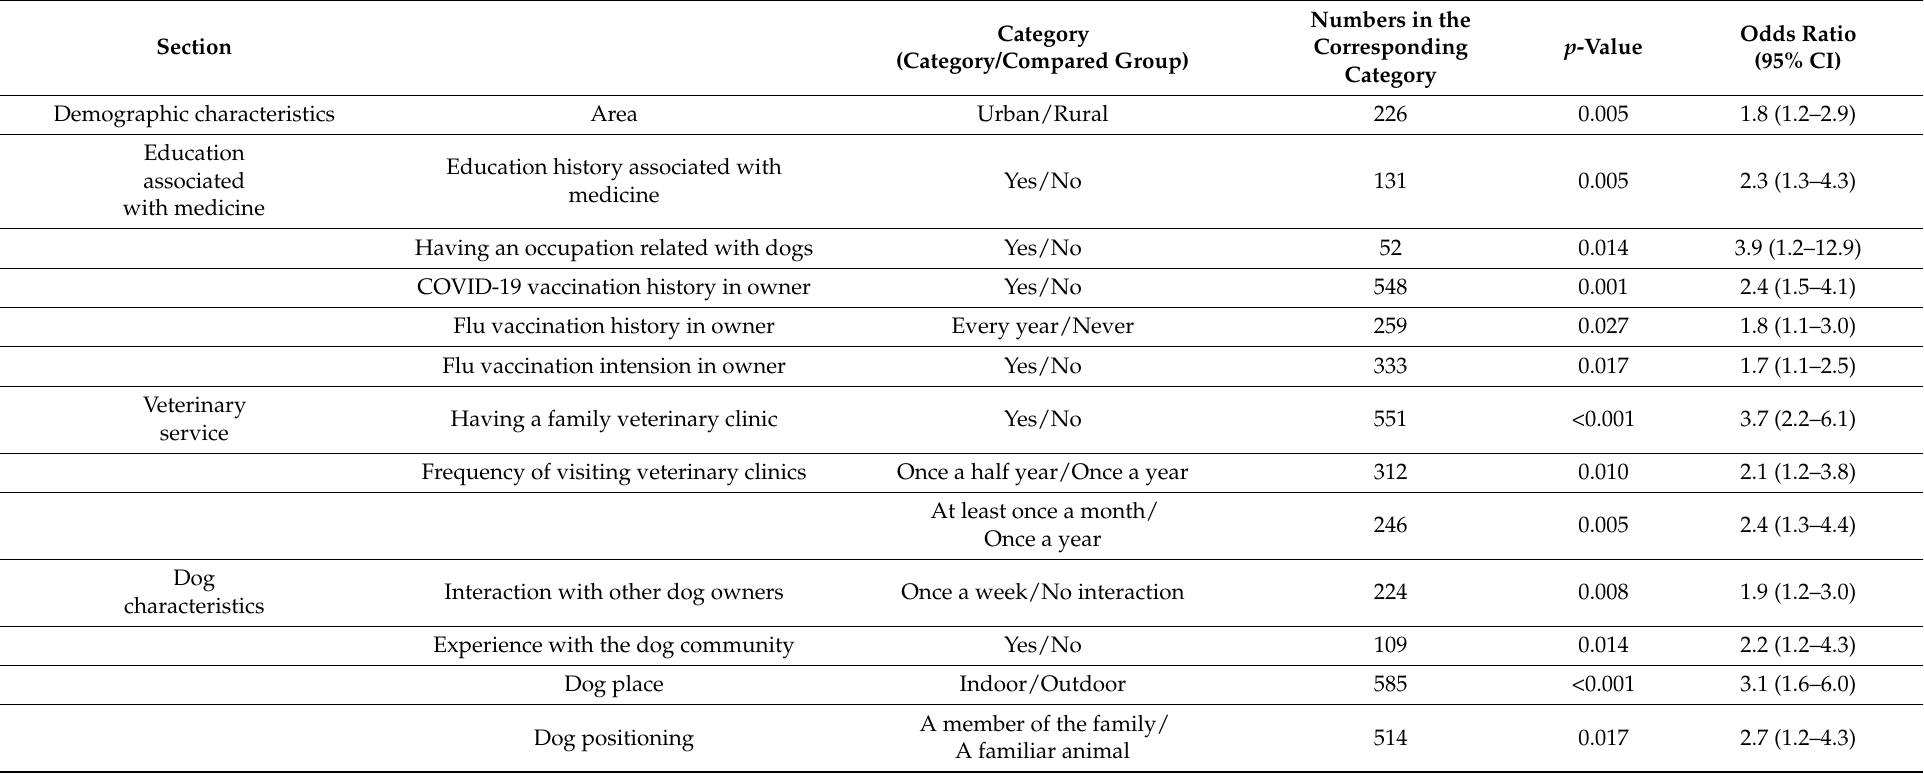
Table 3. Univariate associations between owner characteristics and non-rabies dog